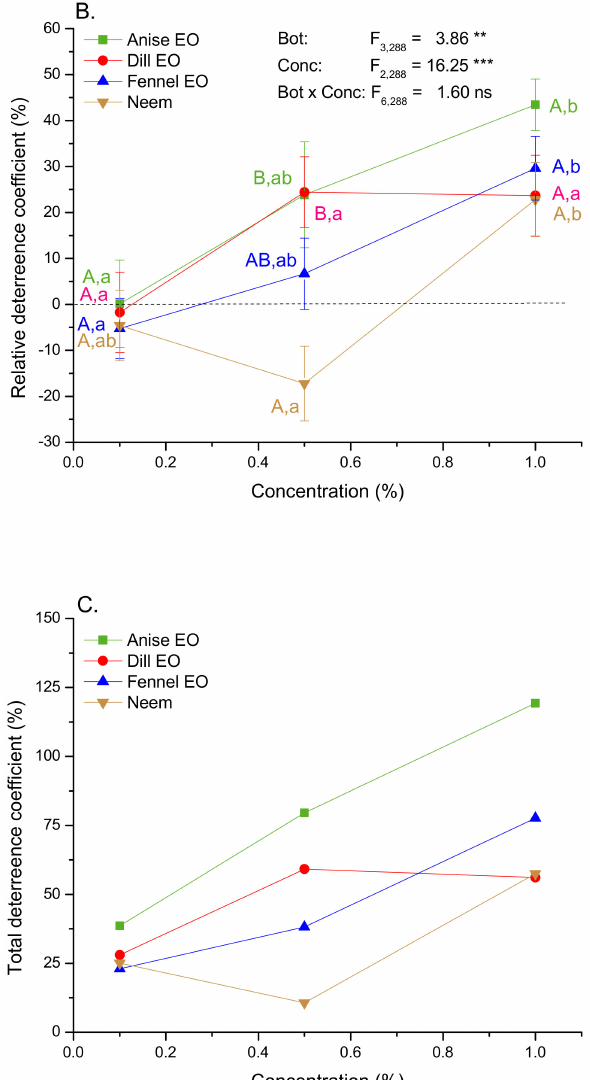
Figure 1. Absolute ( A ), relative ( B ) and total ( C ) deterrence coefficient (mean ± SE) in the 2nd instar GML. F-values were obtained from two-way ANOVA testing significance of the main (botan- ical type − Bot and concentration − Conc) and interaction (Bot × Conc) effects on analyzed traits (** p < 0.01, *** p < 0.001). Different colored letters mark significant differences among EOs and neem within each concentration (capital letters A, B, C), and among concentrations within each EO and neem (small letters a, b, c) (LSM contrasts, p < 0.05).